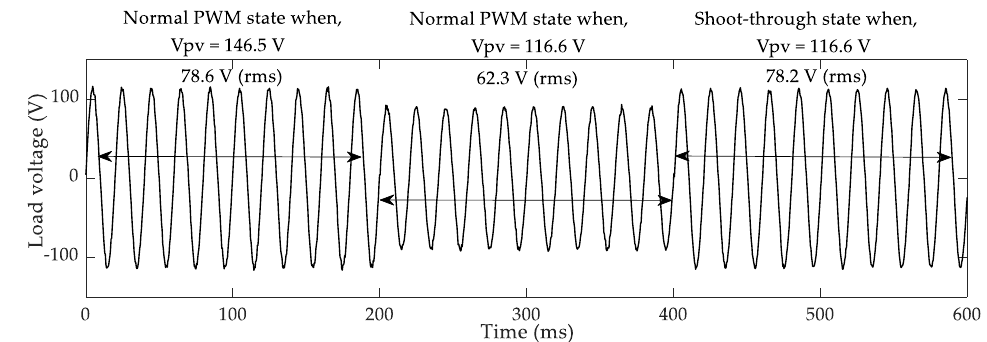
Figure 12. Experimental result for the dynamic voltage compensation.